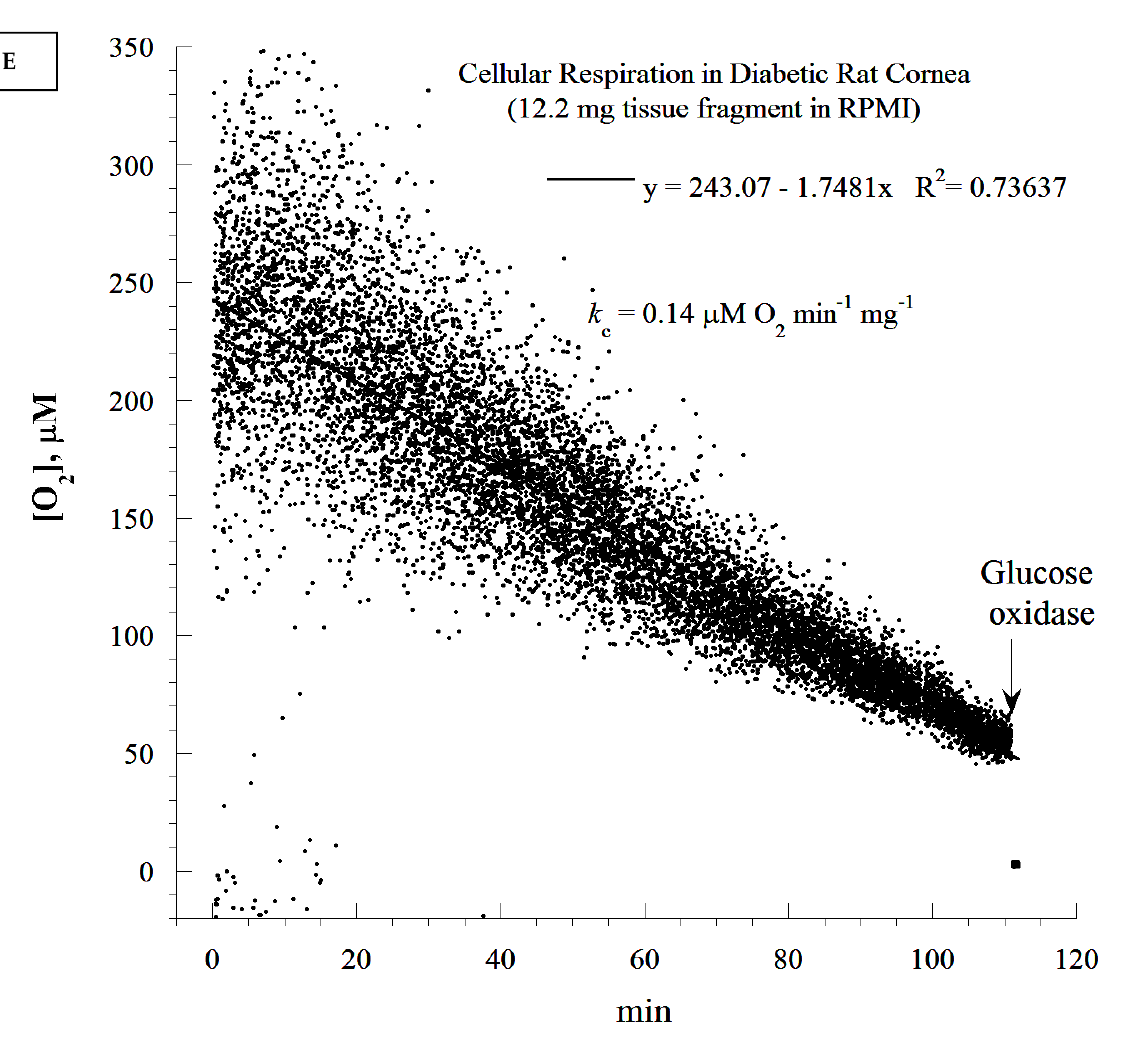
Figure 4. Retina specimens were processed for measurements of O 2 consumption in sealed vials at 37 °C, as described in the Methods section. Representative experimental runs are shown. The rate of cellular respiration ( k , µM O 2 min − 1 ) was set